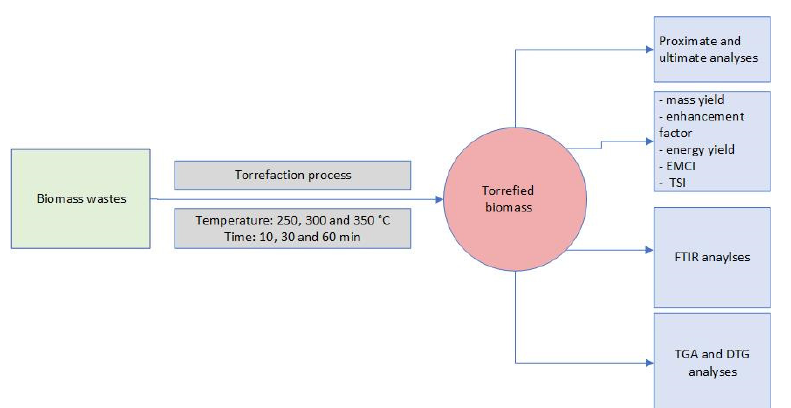
Figure 1. Schematic diagram of the experiment.